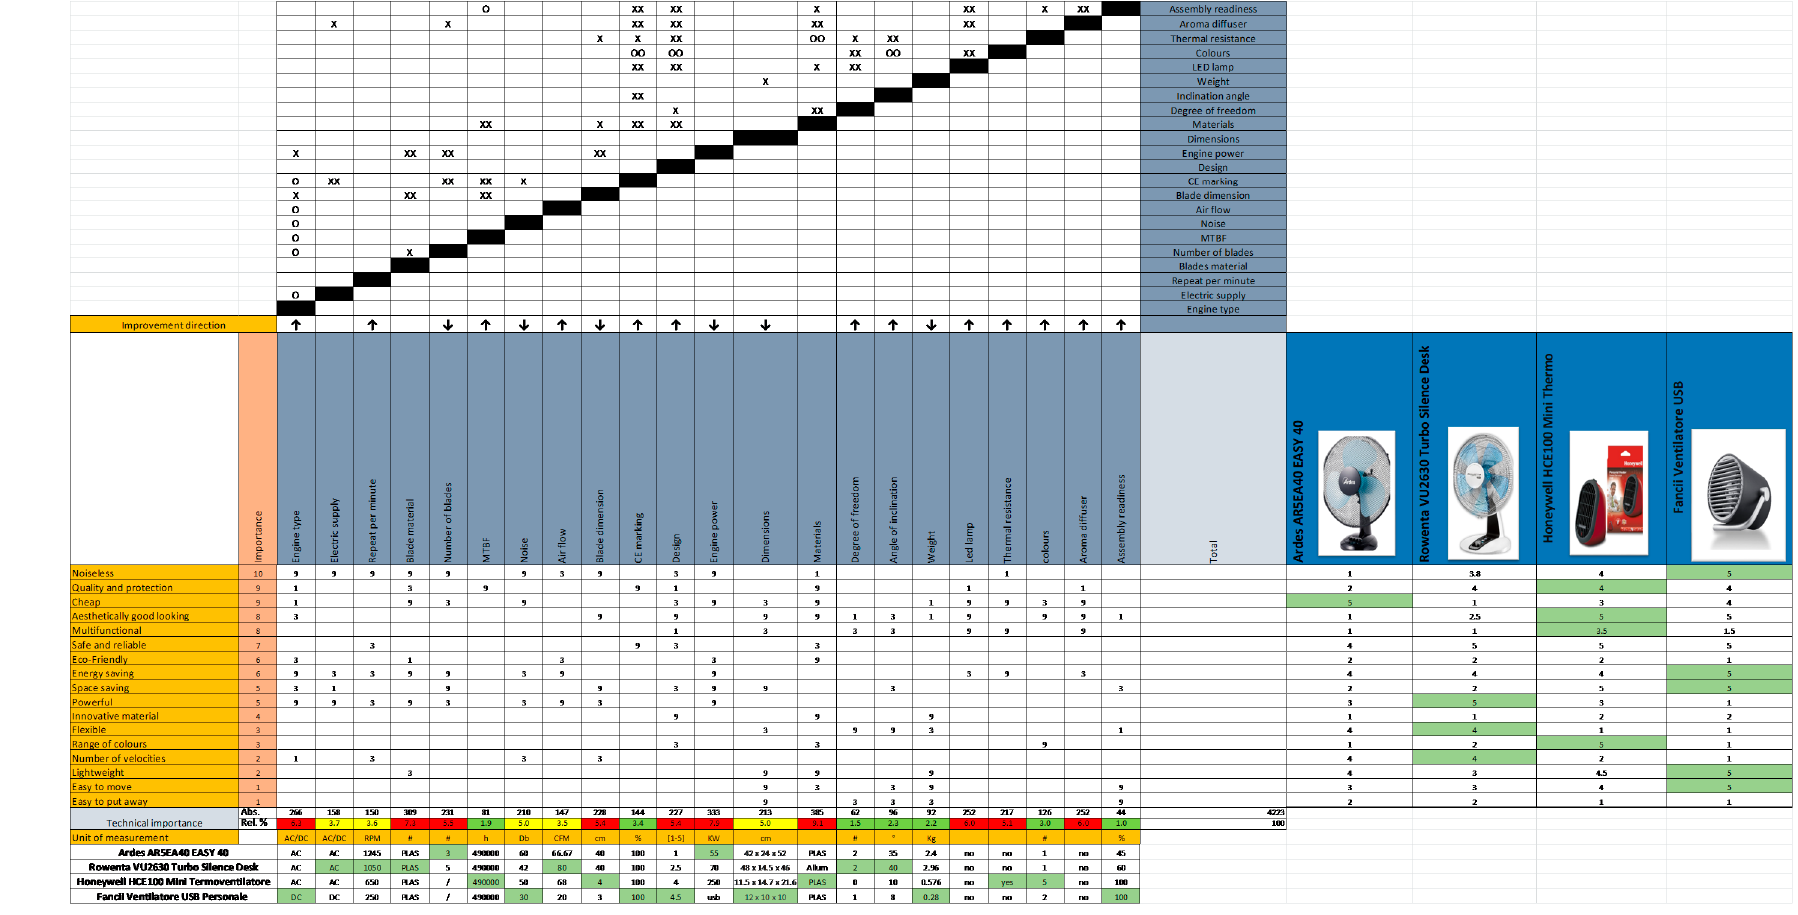
Figure 10. Final QFD matrix.